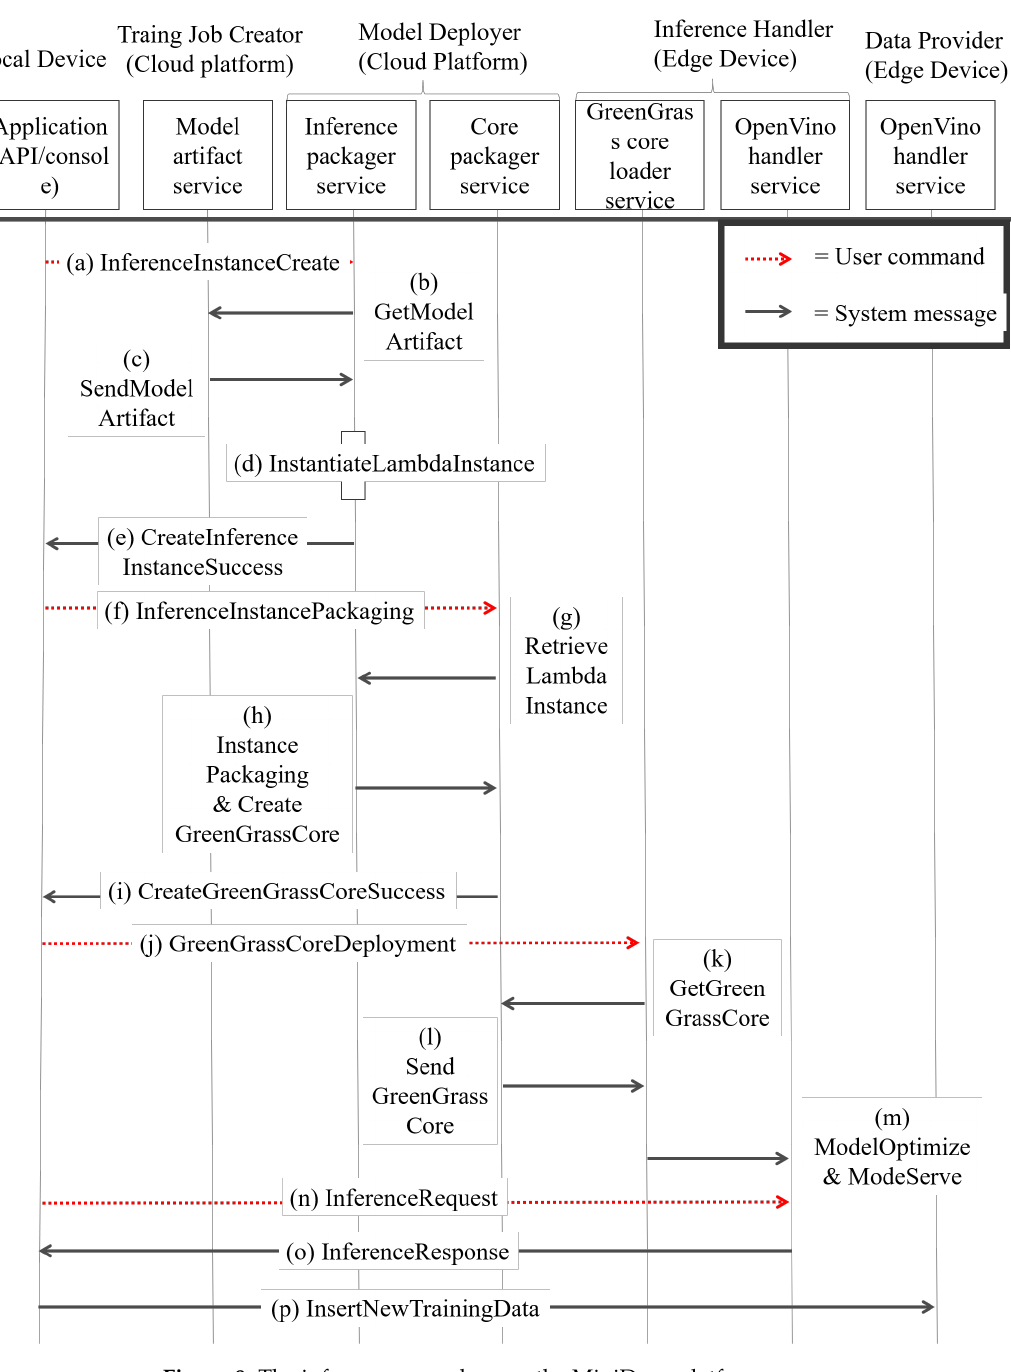
Figure 8. The inference procedure on the MiniDeep